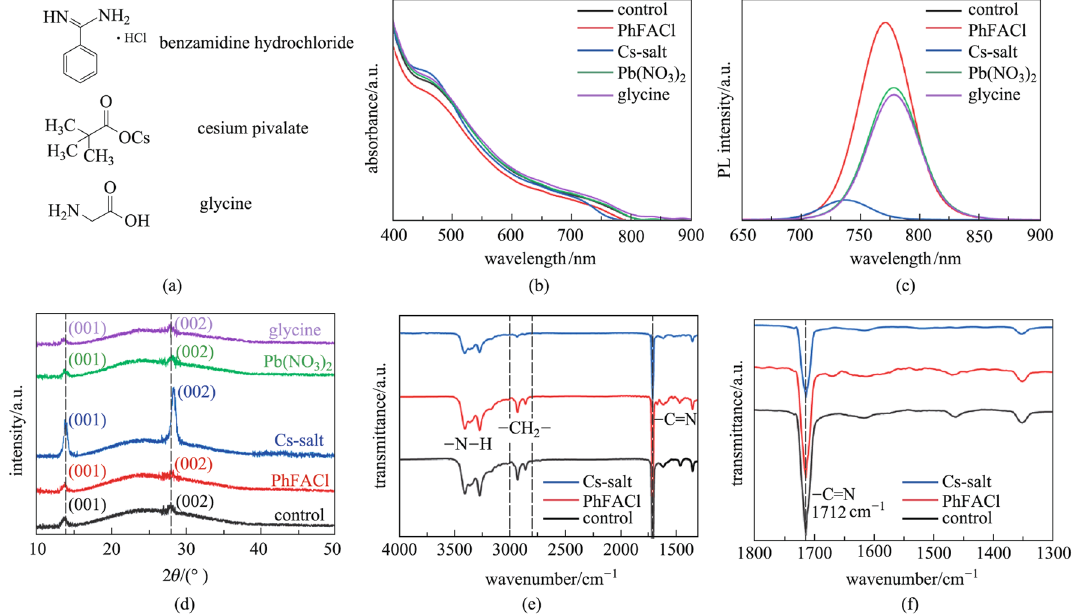
Fig. 3 Ligand exchange of FAPbI 3 PQDs. a Chemical structures of the molecules used for ligand exchange of PQDs. b UV–visible absorption, c PL spectra, d XRD pattern, e FTIR spectra, f zoomed-in view, in the range of 1300 to 1800 cm −1 , of FTIR spectra of the FAPbI 3 PQD solid films with different molecule ligands on the PQD